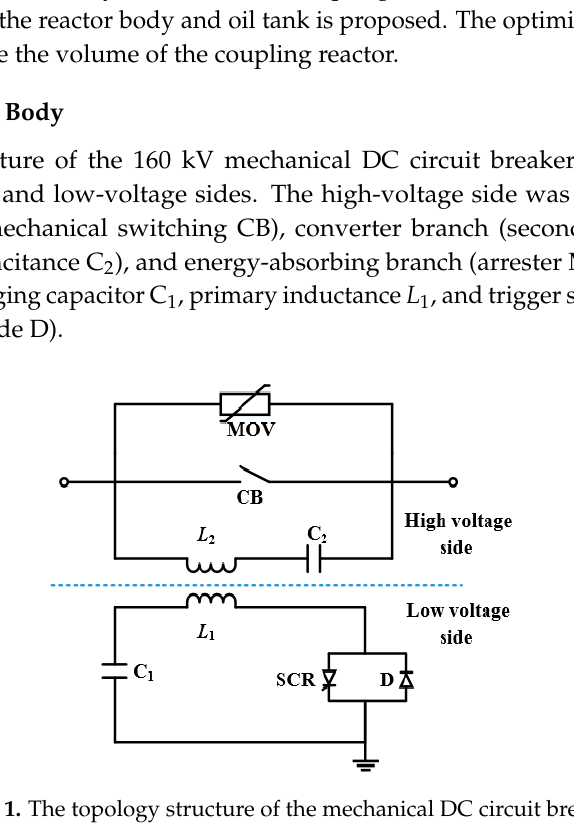
Figure 1. The topology structure of the mechanical DC circuit breaker.